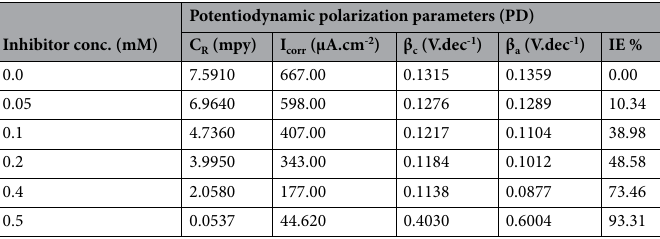
Table 5. Polarisation parameters for MS in 1.0 M HCl with different nonanedihydrazide concentrations.